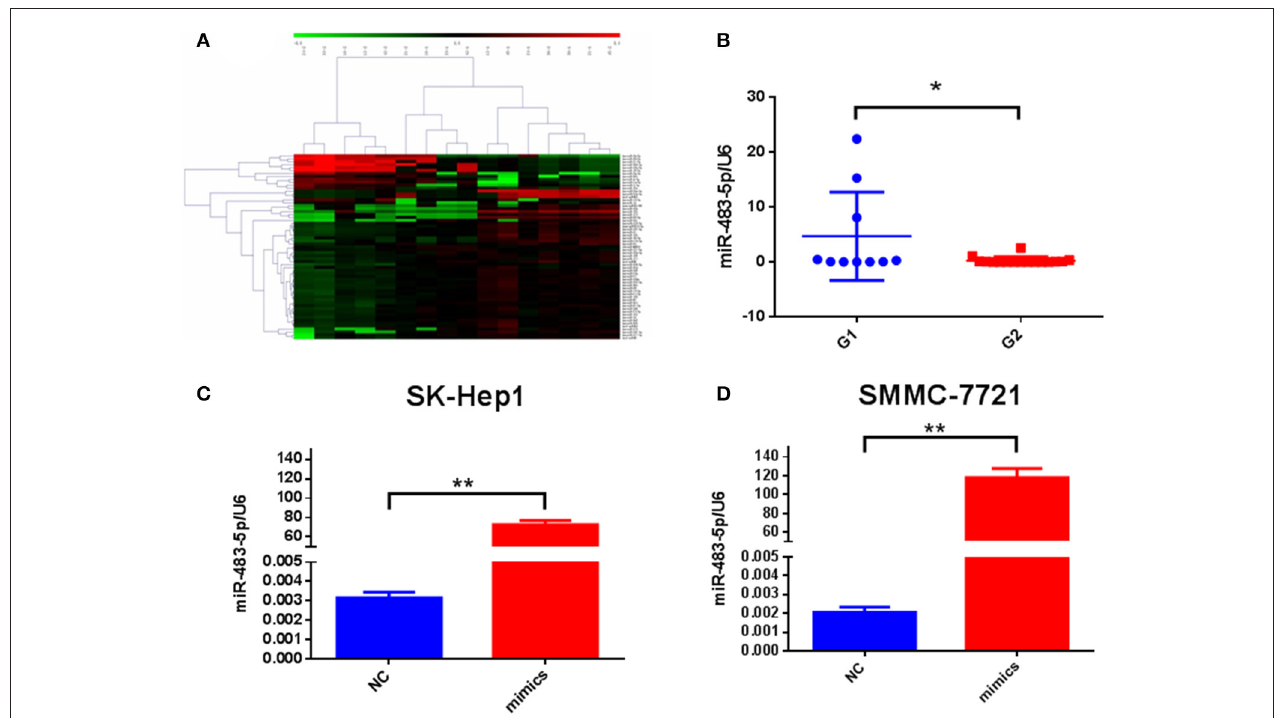
FIGURE 1 | Expression of miR-483-5p in RHCC tissues and cells. (A) miRNAs array screened miRNA expression profiles. (B) Differential expression of miR-483-5p between two groups. (C,D) Transfection efficiency of miR-483-5p mimics in SK-Hep1/SMMC-7721 cells. * p < 0.05; ** p <